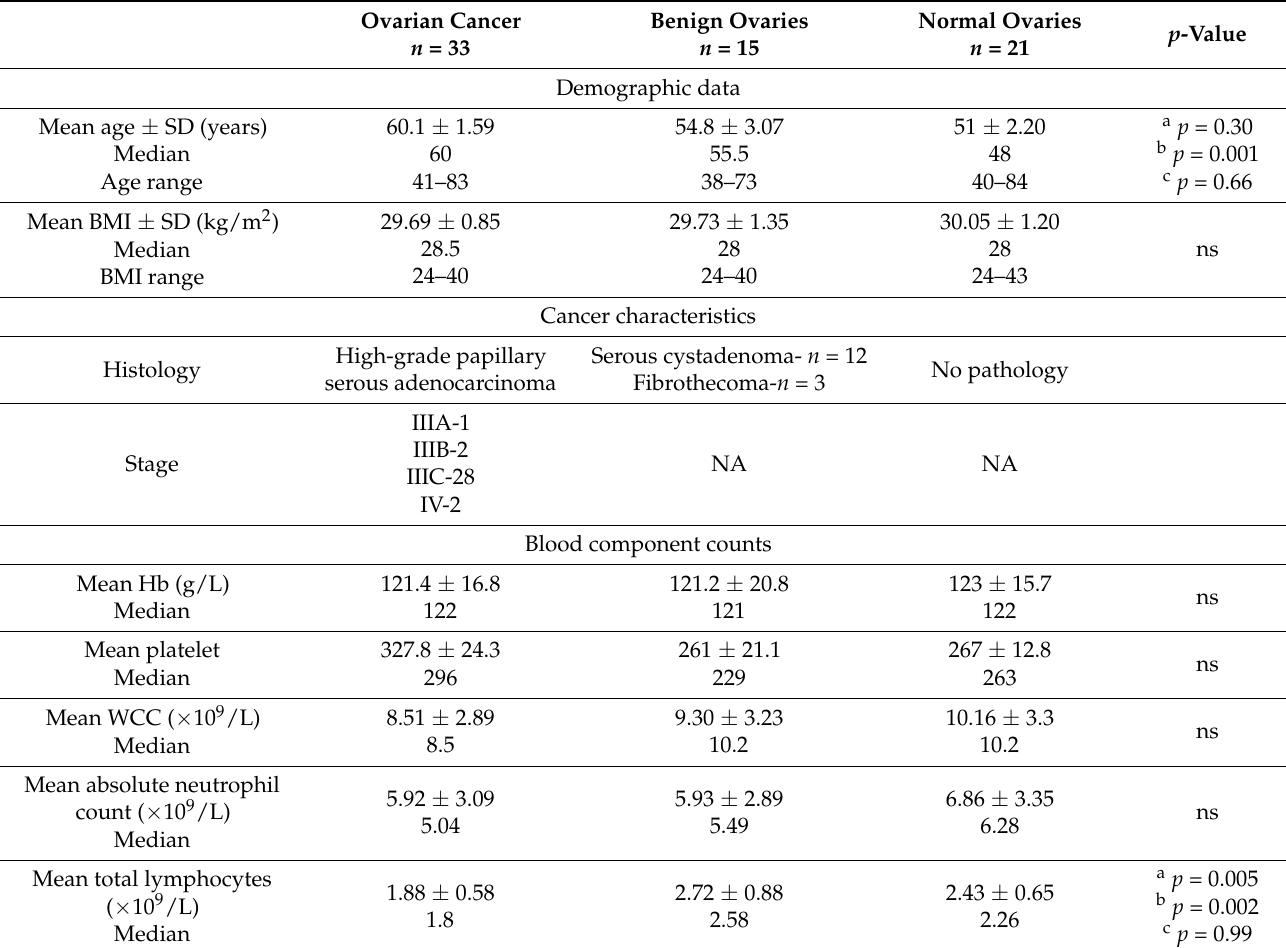
Table 2. Characteristics of study patients according to tumour